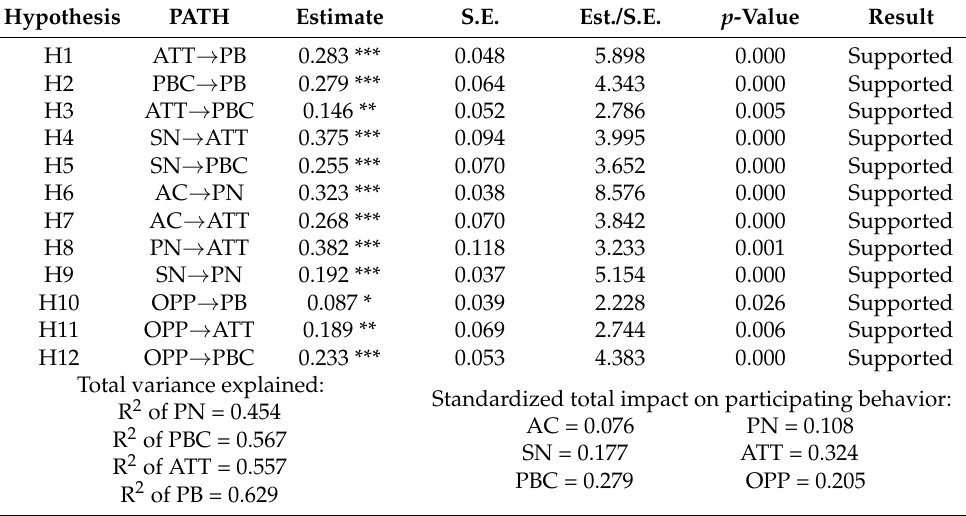
Table 5. Standardized path coefficients of the structural